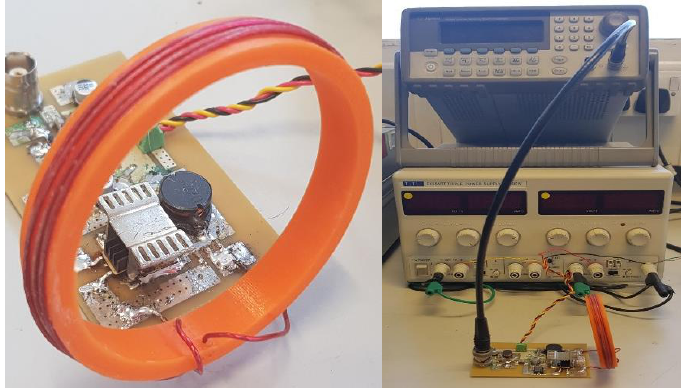
Figure 2. Experimental set-up for the PA and the solenoid coil as the output stage. On the left a zoomed-in image of the PA with the solenoid coil is shown, while on the right the PA, DC power supply and the function generator for providing the input signal to the PA are shown from bottom to top, respectively.